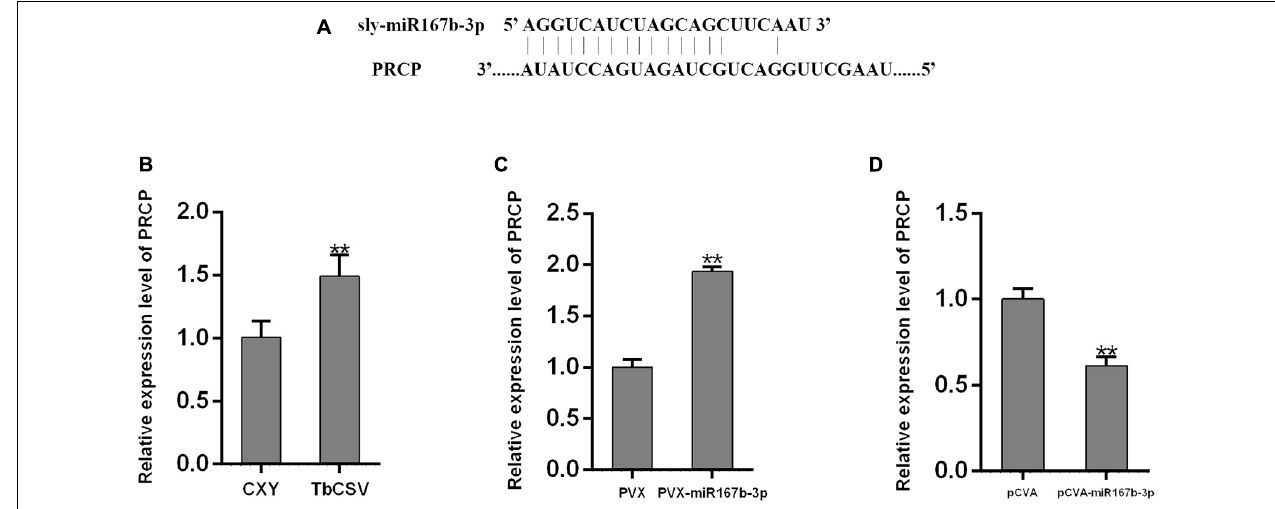
FIGURE 5 | Analyses of the expression of nbe-miR167b-3p target gene PRCP through qRT-PCR. (A) The binding site of nbe-miR167b-3p on the mRNAs of potential target was localized at the encoding sequence. (B) The mRNA levels of PRCP were up-regulated in TbCSV-infected N. benthamiana plants. (C) The mRNA levels of PRCP were up-regulated in nbe-miR167b-3p-suppressed leaves. (D) The mRNA levels of PRCP were down-regulated in nbe-miR167b-3p-overexpressed leaves. Significance of difference between treatments (* p < 0.05; ** p < 0.01) was determined by the Student’s t